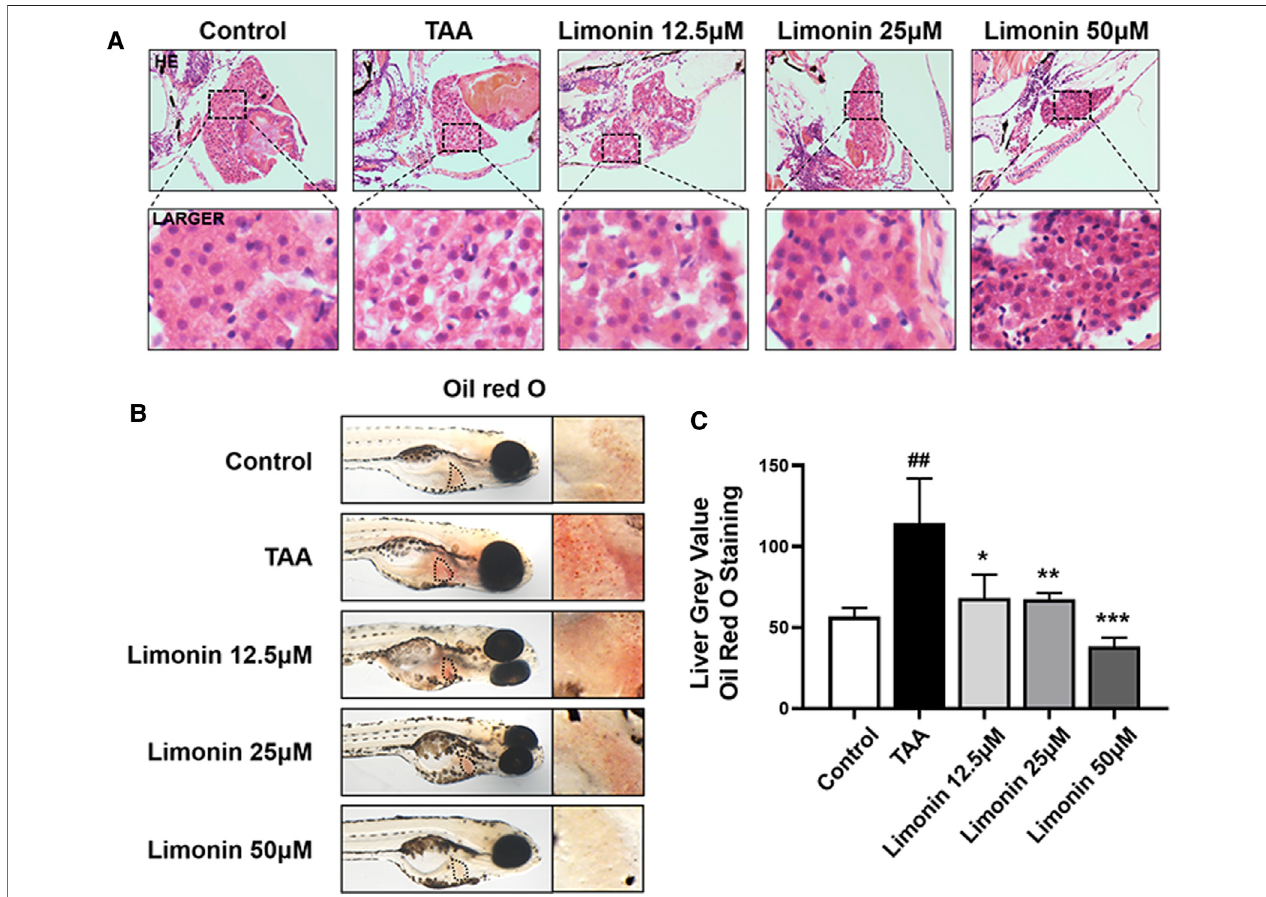
FIGURE 3 | Limonin alleviated TAA-induced liver hepatic steatosis in zebra fi sh larvae. (A) H&E staining of zebra fi sh larvae. Figures are magni fi ed as × 400 ( n (cid:1) 5 – 7 pergroup). (B) Whole fi shstainingwithOilRedO.Figuresaremagni fi edas × 50( n (cid:1) 3pergroup). (C) QuantitativeanalysisofthelivergrayvalueofOilRedOusingImageJ software. Data are shown as the mean ± SD. # p < 0.05, ## p < 0.01, ### p < 0.001 vs control group; * p < 0.05, ** p < 0.01, *** p < 0.001 vs TAA